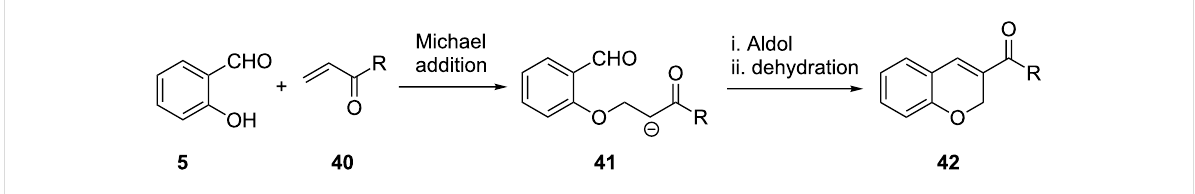
Scheme 16: Tandem reaction of salicylaldehyde and α , β -unsaturated compounds.